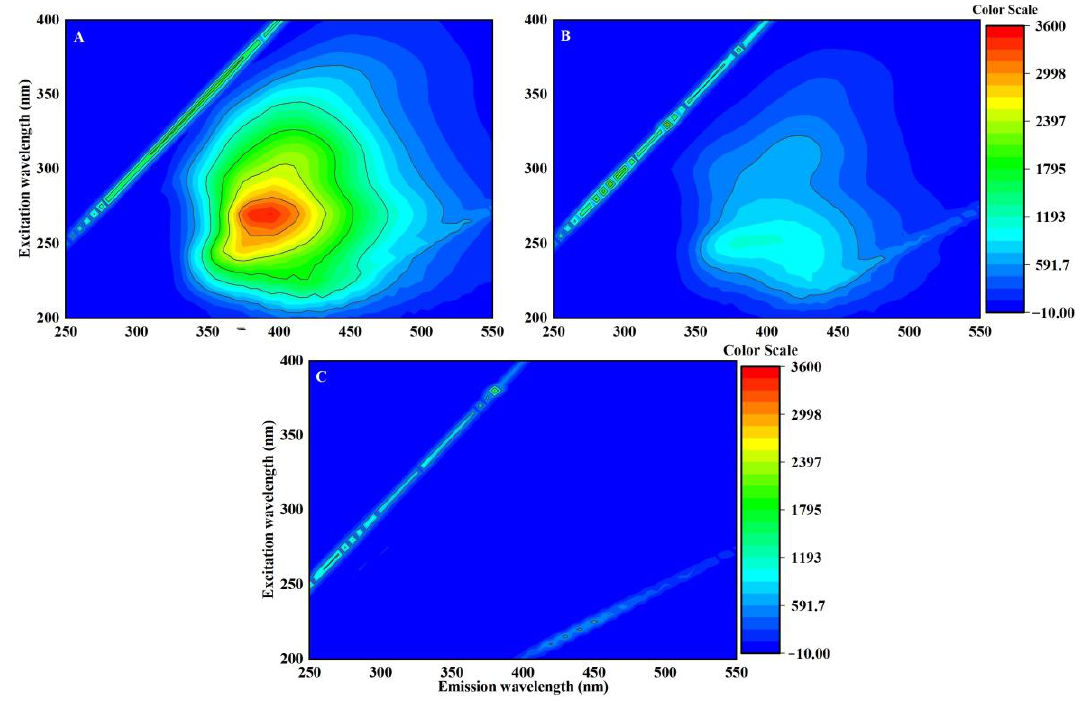
Figure 4. Fluorescence excitation-emission matrices of S500 ( A ), S700 ( B ), and H 2 O ( C ).